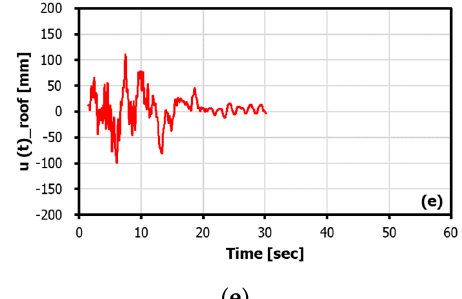
Figure 11. Dynamic response and roof displacement of the model for the Kobe earthquake; ( a ) base acceleration, ( b ) 4th floor acceleration, ( c ) 7th floor acceleration, ( d ) roof acceleration, and ( e ) roof displacement.